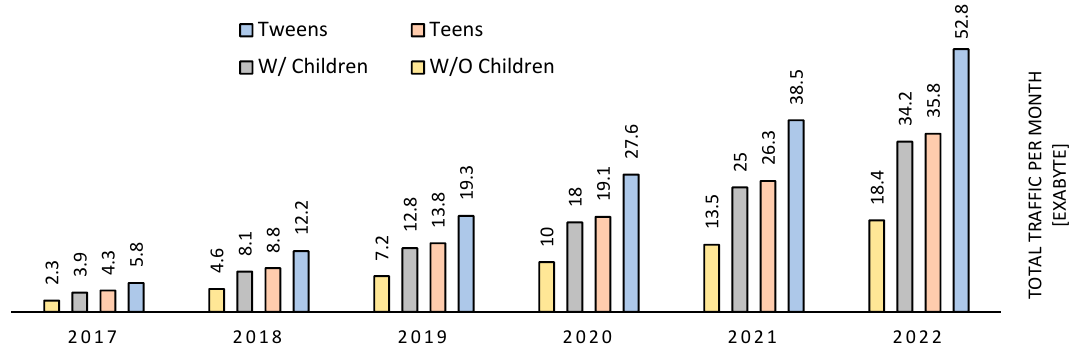
Figure 15. Total traffic per month per year for new behavioral clusters.